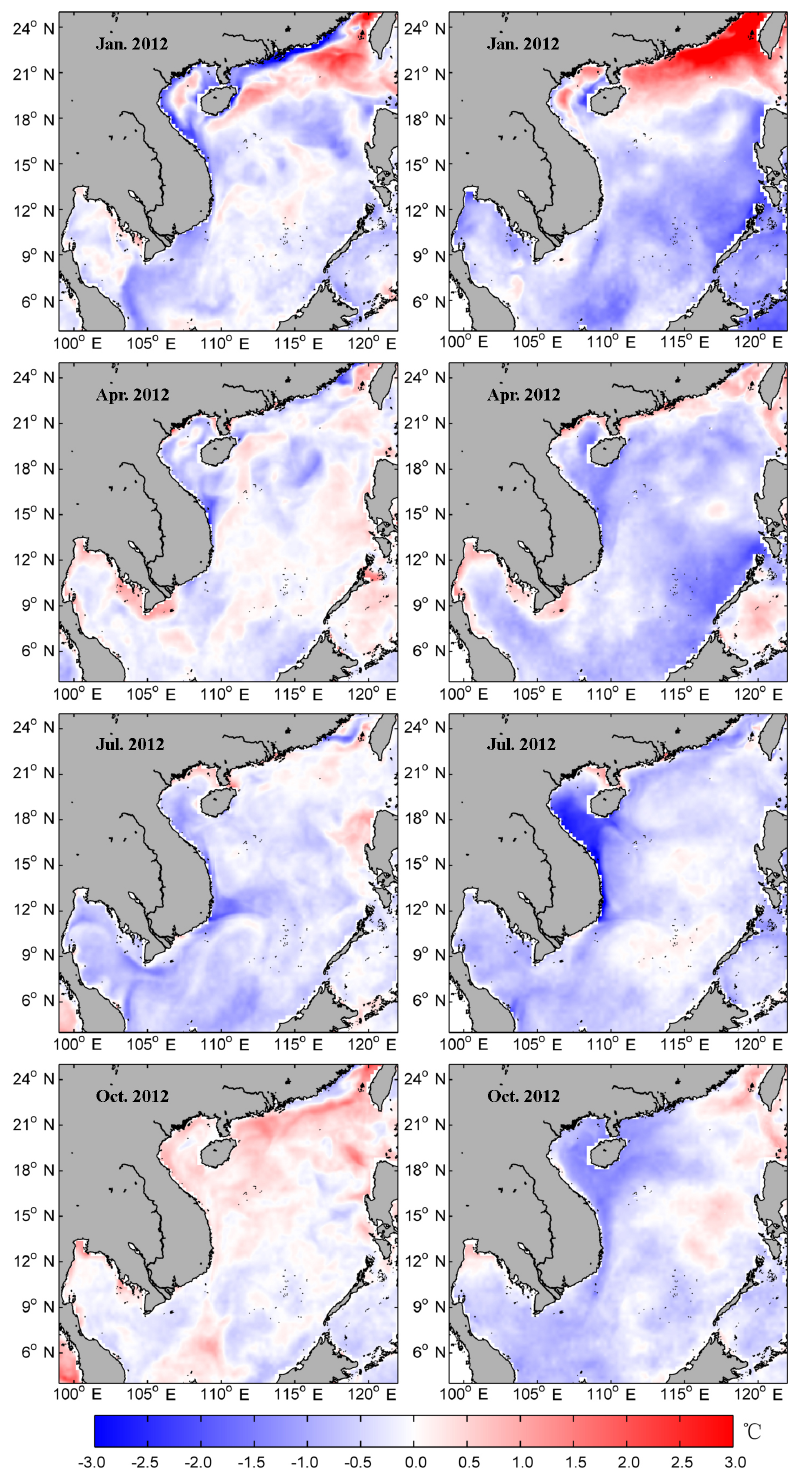
Figure 4. The monthly mean SST error between Mercator Océan (left panels), SCSOFS (right panels), and MGDSST in January, April, July, and October